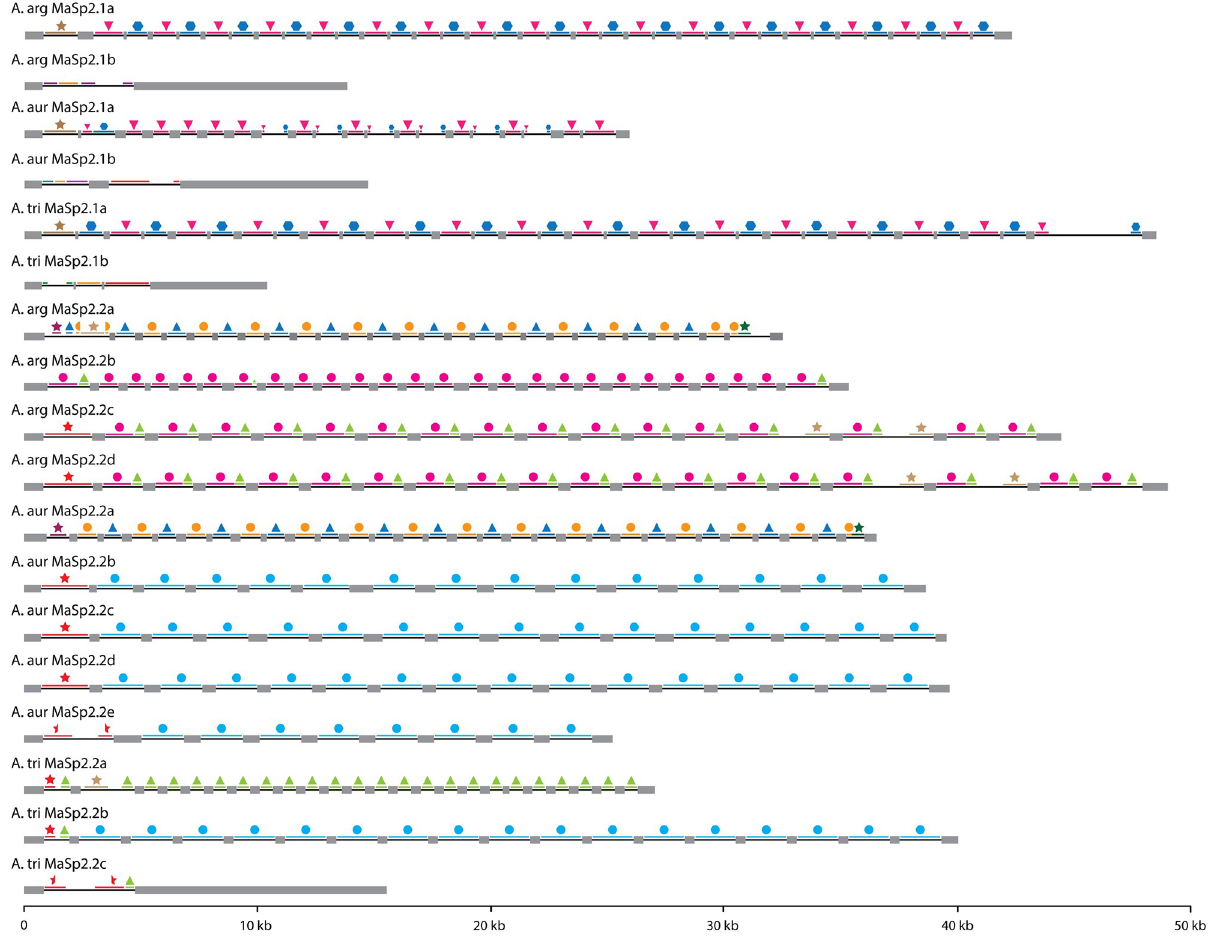
Fig 2. MaSp2.1 and MaSp2.2 gene structure. Intron/exon structure and homology relationships among introns is depicted. The exons are represented by gray rectangles and the introns by black lines. The colored lines and shape combinations above each intron indicate regions of sequence similarity shared among genes (each unique combination of color and shape represents a separate homology